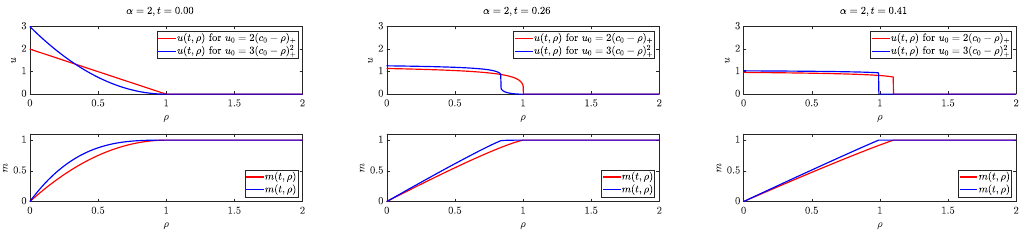
Fig. 8: Behaviour of two different powers with waiting time. See a movie simulation in the supplementary material [1, Video 4].